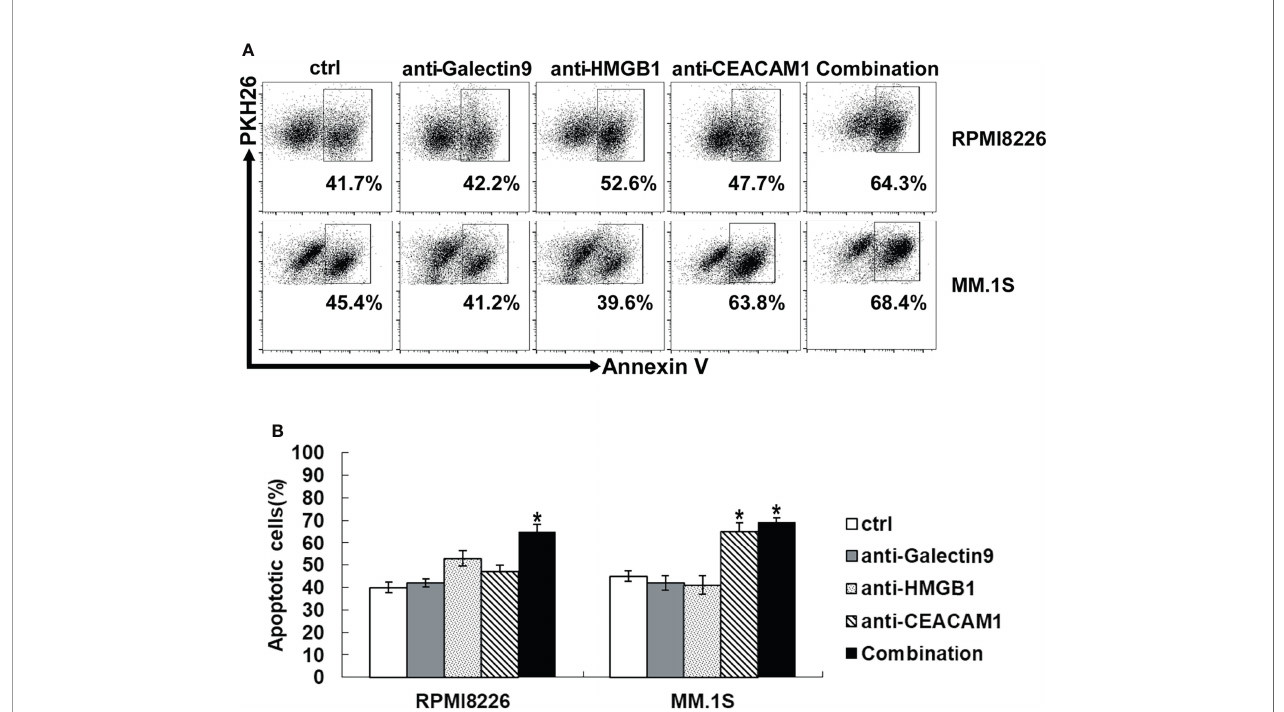
FIGURE 6 | Tim-3 ligands combined blockade enhanced NK cell-mediated natural cytotoxicity against human MM cell lines. exNK was used as effector (E) cells and human MM cell lines were used as target (T) cells. MM cell lines were pre-incubated by 10 m g/ml anti-Tim-3 ligands antibody. Cytotoxicity activity of NK cells was tested by PKH26/Annexin-V stain. * P < 0.05 versus control NK cells. (A) Cytotoxicity activity of NK cells. (B) Statistical Analysis of (A)